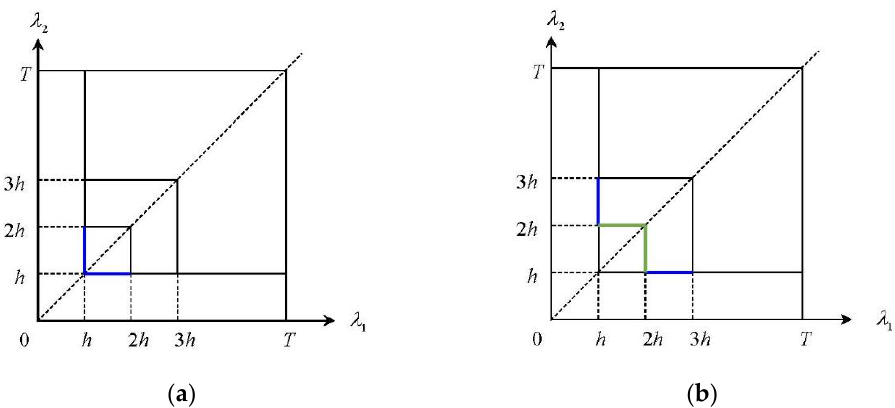
Figure 5. Geometric illustration of the location of the boundaries between the domains Ω 𝑘 : ( a ) The boundary between the domains Ω 0 and Ω 1 is highlighted in blue; ( b ) The boundary between the domains Ω 0 and Ω 2 is highlighted in blue, the boundary between the domains Ω 1 and Ω 2 is highlighted in green.